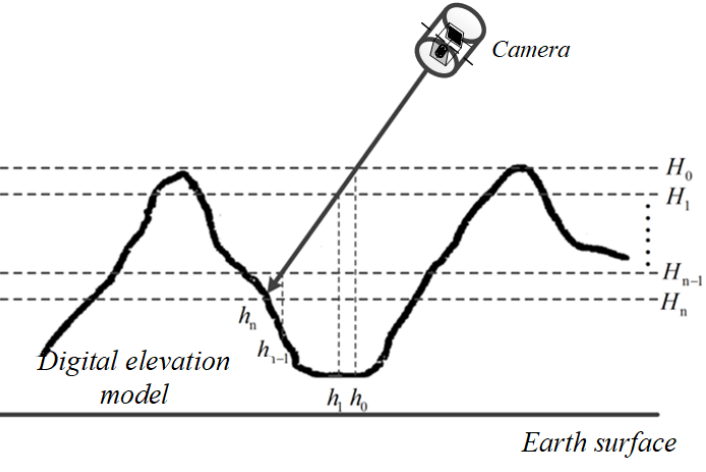
Figure 8. Schematic of target location model based on DEM.